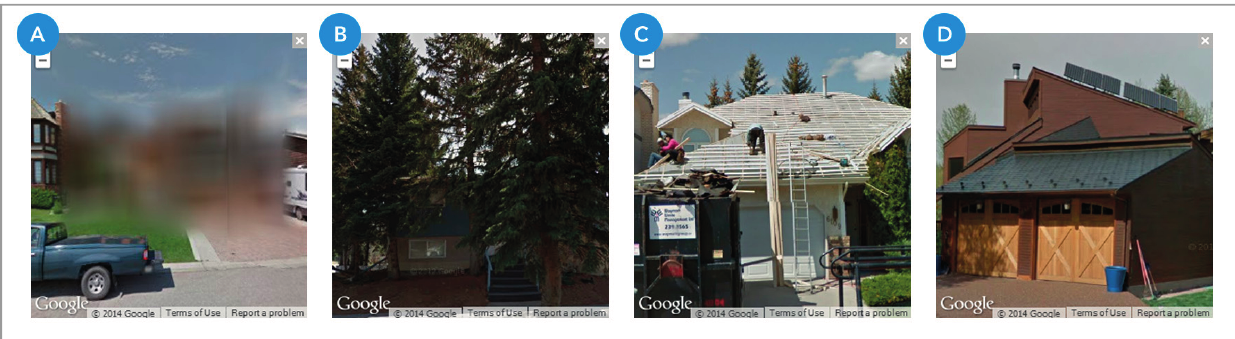
Figure 10. Limitations of the Google Street View imagery with roofs that are ( A ) blurred; ( B ) surrounded by trees; ( C ) under-construction; or ( D ) covered with solar